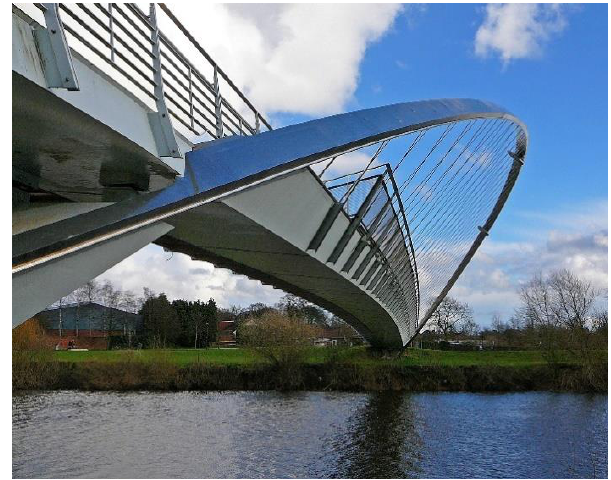
Figure 3. York Millennium footbridge (Photo: Tim Green. Creative Commons).